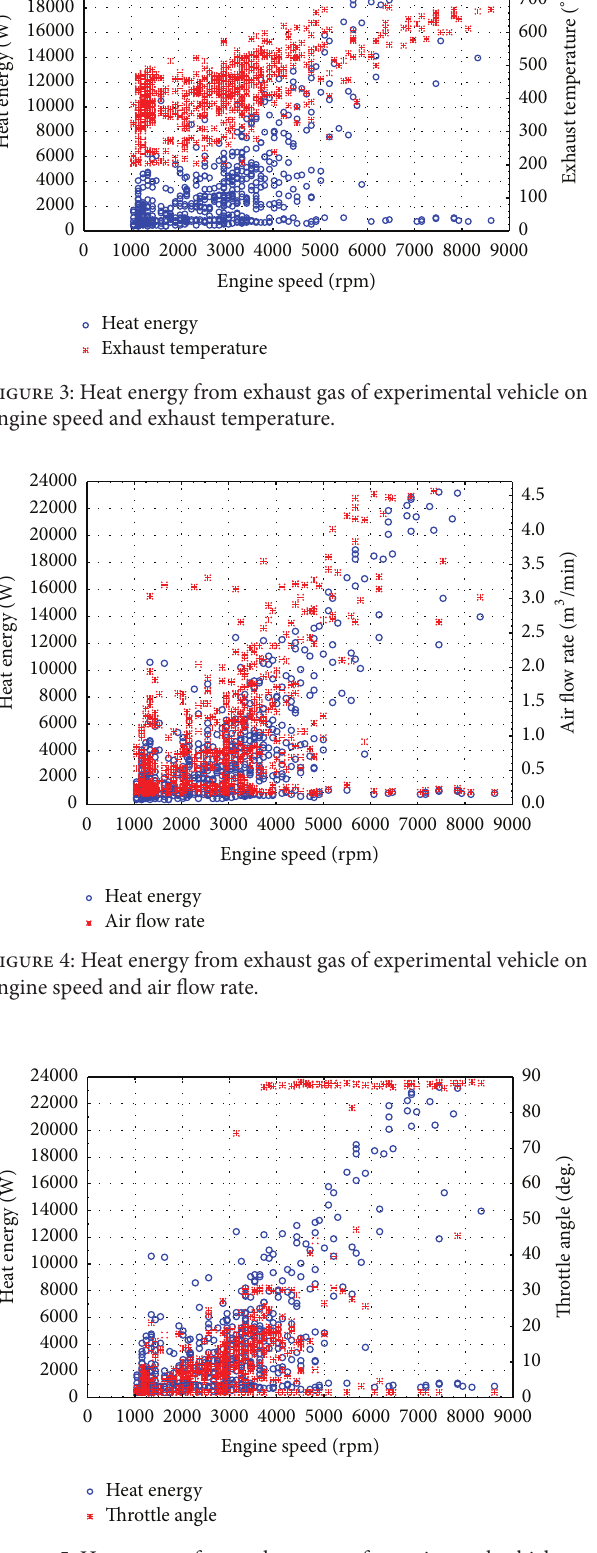
Figure 5: Heat energy from exhaust gas of experimental vehicle on engine speed and throttle angle.